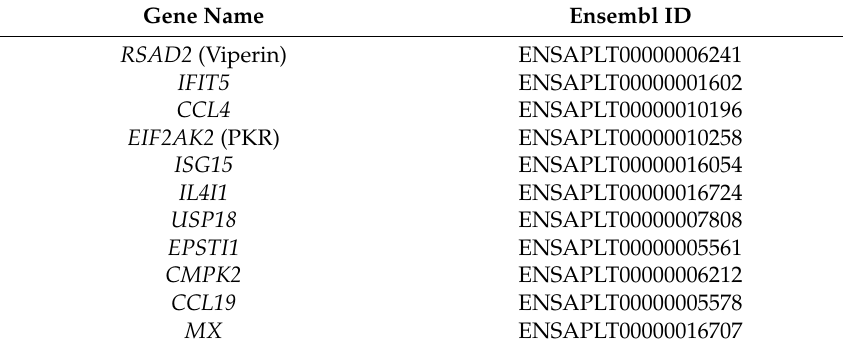
Table 1. Most highly upregulated transcripts in three ducks infected with HPAI A/duck/Hubei /49/2005 (H5N1) at 1 dpi, relative to mock-infected controls, in descending order. Transcriptome data from the NCBI Sequence Read Archive (control transcriptome accession: SRR797835,